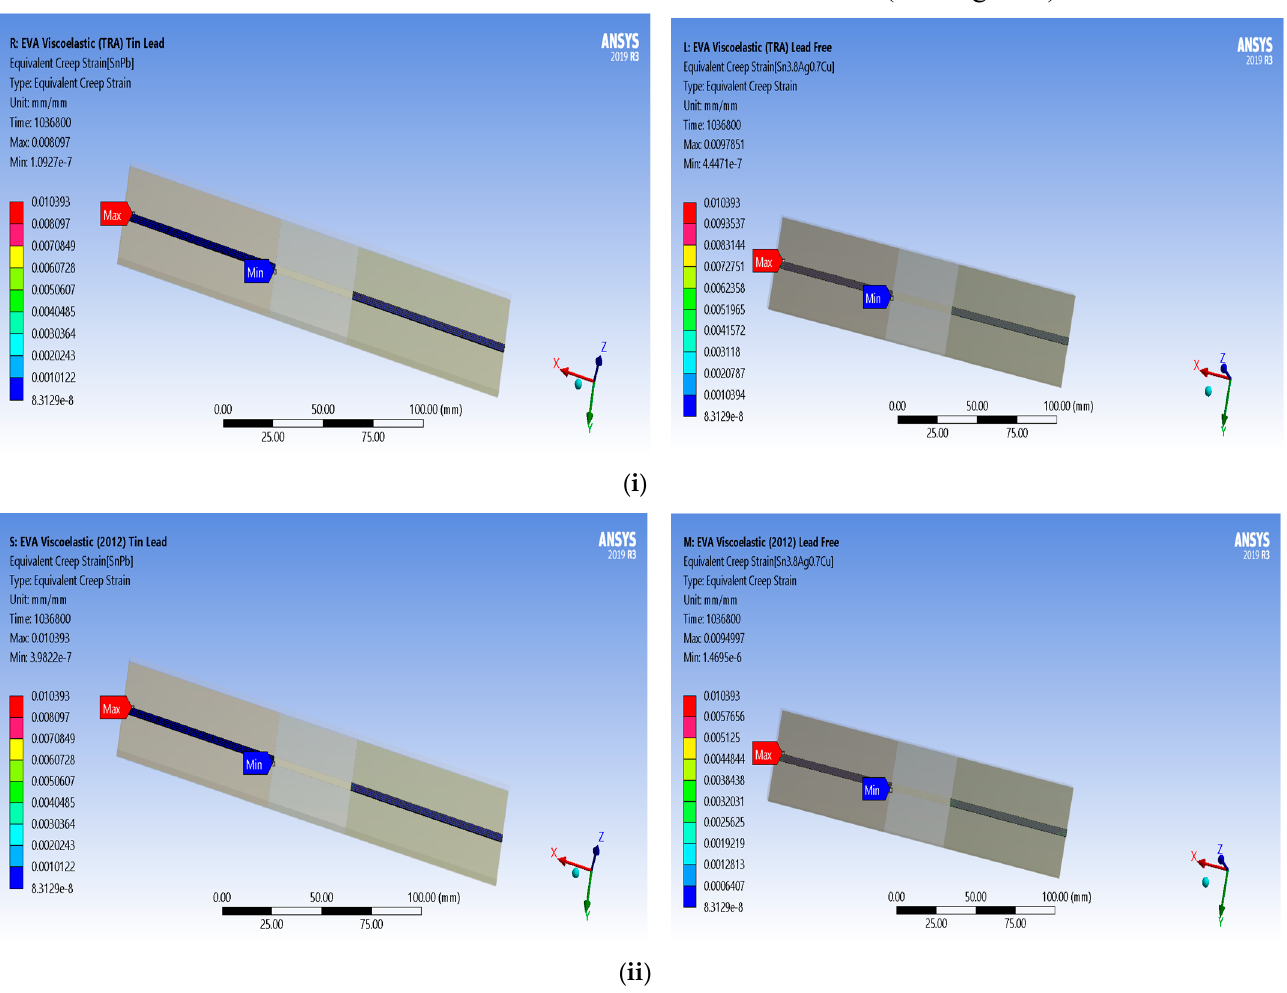
Figure 7. Equivalent creep strain distribution on PbSn solder and Pb-free (Sn 3.8 Ag 0.7 Cu) solder for: ( i ) TRA, ( ii ) 2012 thermal cycles.